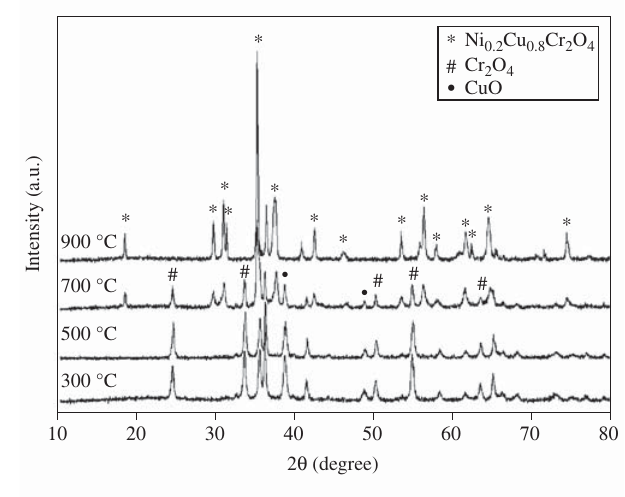
relative peak intensity of spinel with respect to CuO and Cr increasing synthesis temperature. This indicated ongoing crystalliza- tion of spinel from its precursors. The synthesis of spinel also affected particle size distribution in the resulting powder (Figure 3). Although slight, it is possible to notice that the average particle size (D50) of the powder, representative of powder agglomerates, steadily decreased from ~10 (cid:77) m to ~ 6 (cid:77) m as the calcining temperature increased from